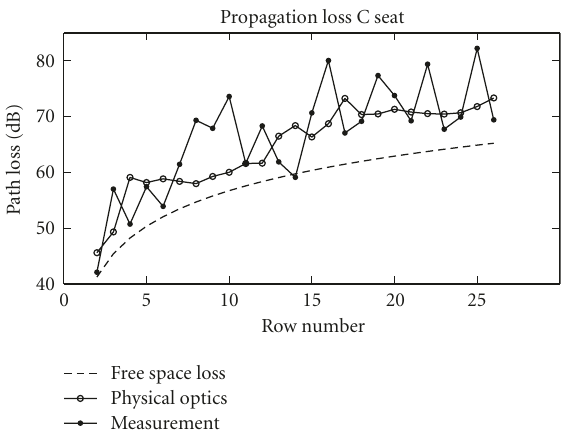
Figure 17: Comparison of simulated and measured values, C